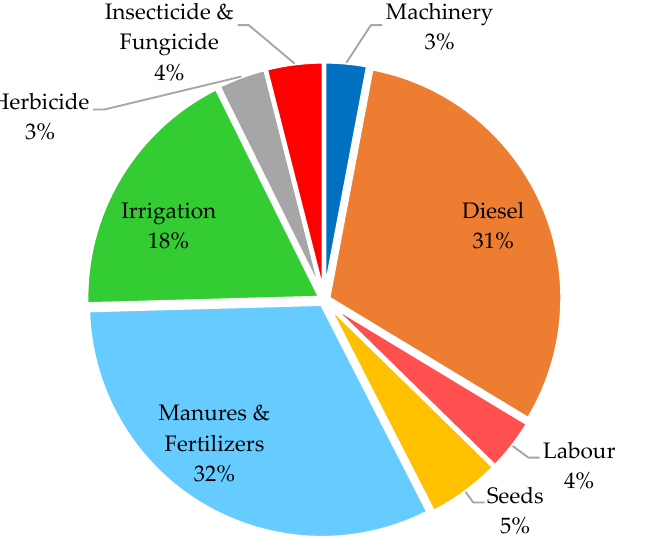
Figure 2. Source-wise inputs energy (MJ ha −1 ) used for fodder maize varieties sown under different nutrient management practices (mean of two years).